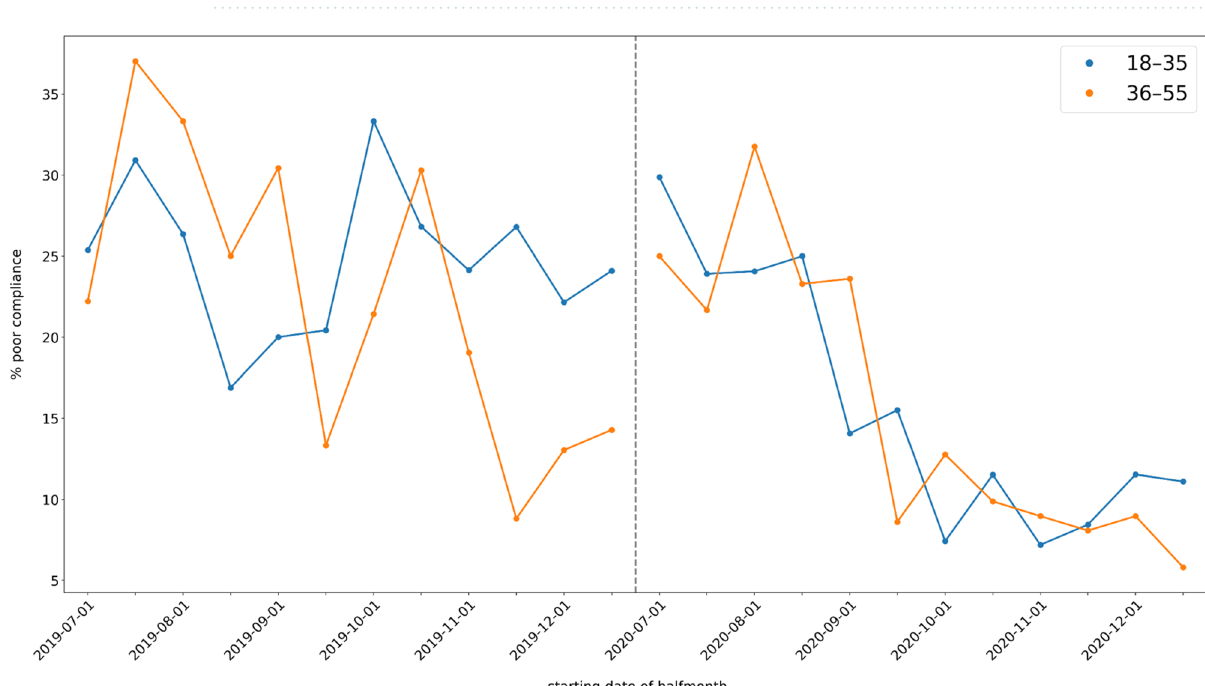
Figure 4. Mean poor compliance by starting date of treatment, split by age range. The dashed vertical line indicates the gap between the two segments. The age range 56–64 was excluded from the figure due to the low number of patients in this age